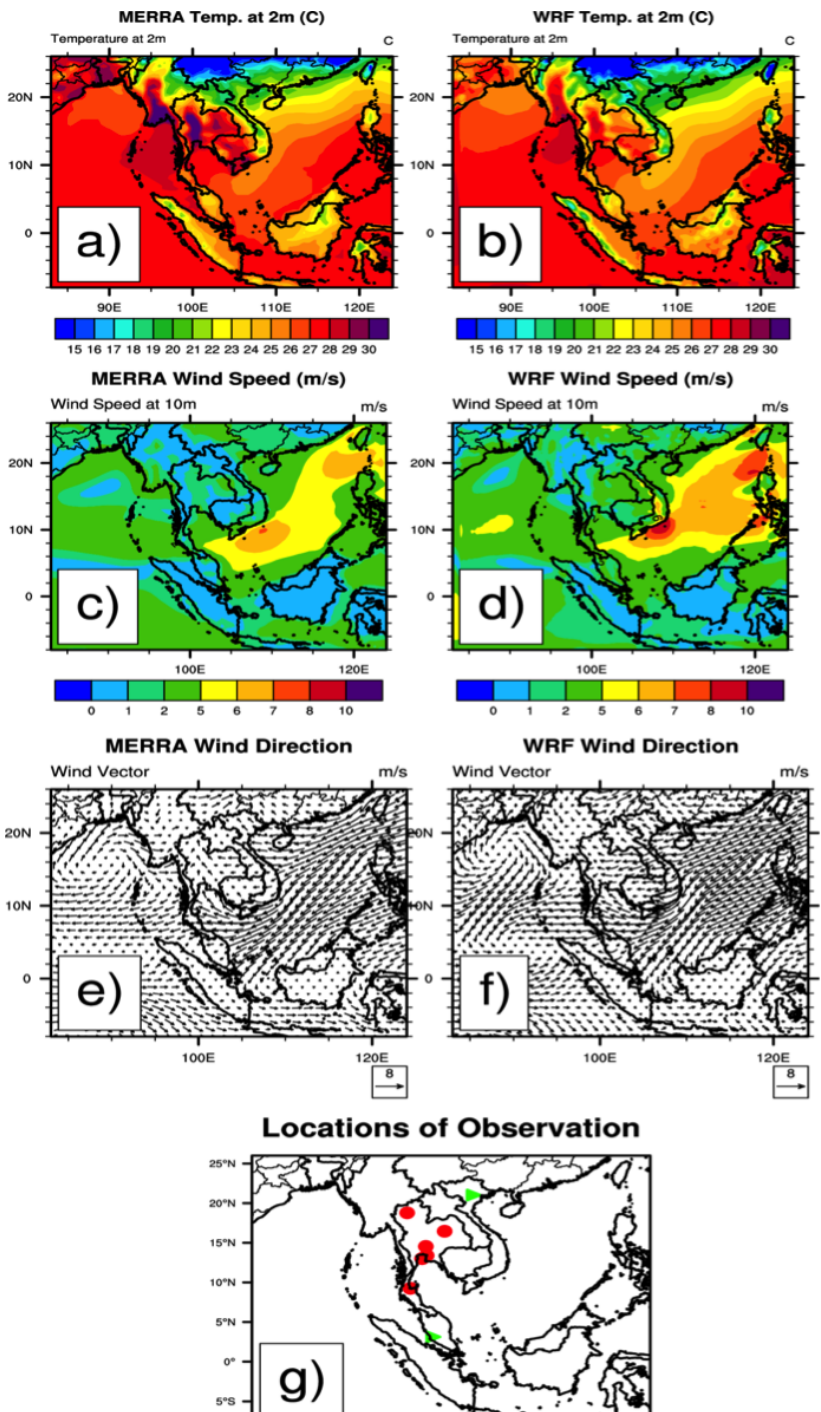
Figure 5. March 2008 monthly averaged (a) 2m temperature ( ◦ C) from MERRA, (b) 2m temperature ( ◦ C) from WRF, (c) 10m wind speed (ms − 1 ) from MERRA, (d) 10m wind speed (ms − 1 ) from WRF, (e) 10m wind direction from MERRA, and (f) 10m wind direction from WRF. (g) Locations of ground-based CO and O 3 measurements (red dot) and ozonesonde sites (green triangle) are